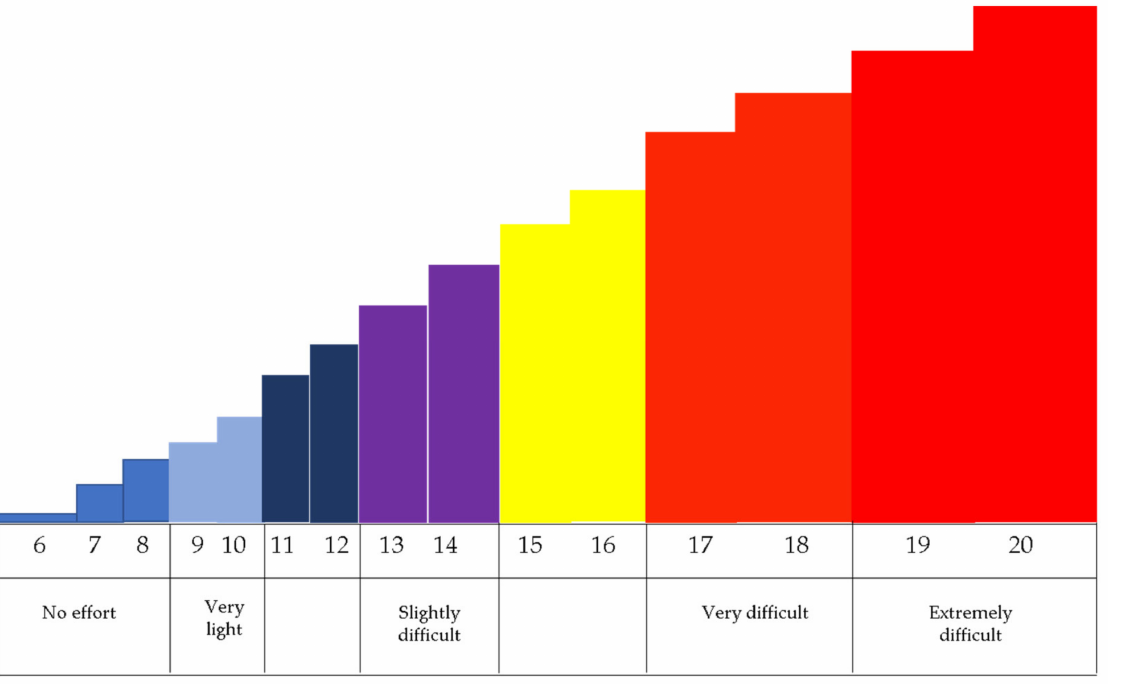
Figure 1. The Borg Scale for Perceived Effort. After the Virtual Reality session, the following question was asked to the participants: “How exhausting was this